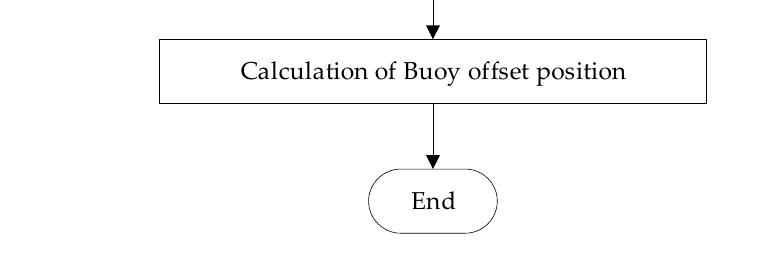
Figure 1. Buoy offset position-prediction process.